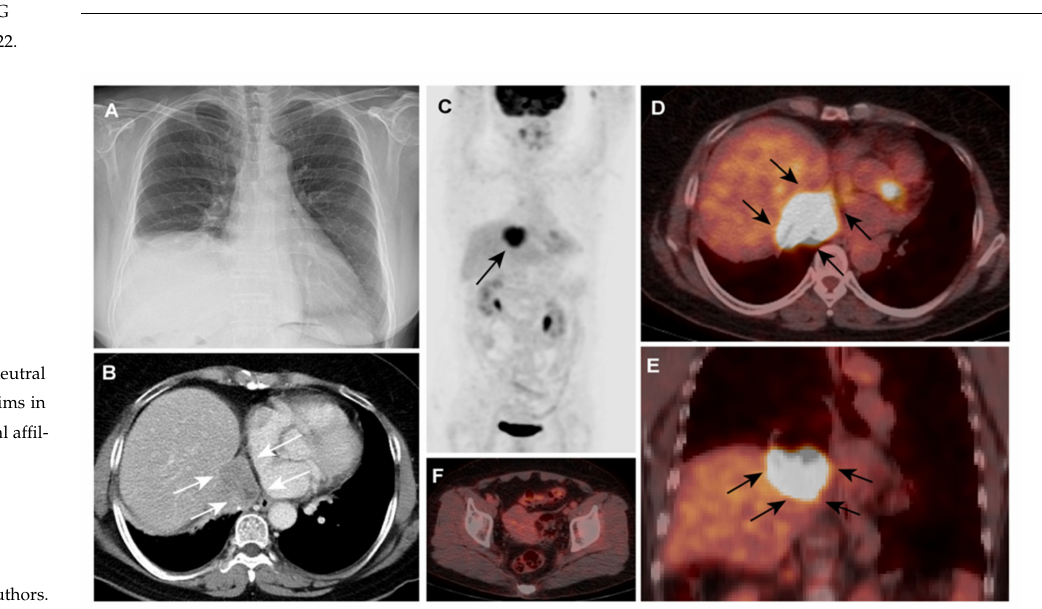
Figure 1. A 67-year old woman was admitted to our hospital for the elevation of right hemidiaphragm that was incidentally found by chest radiography at a regular checkup (Figure 1, Panel A). Her medical history was unremarkable (e.g., no trauma or surgery), and she had no specific